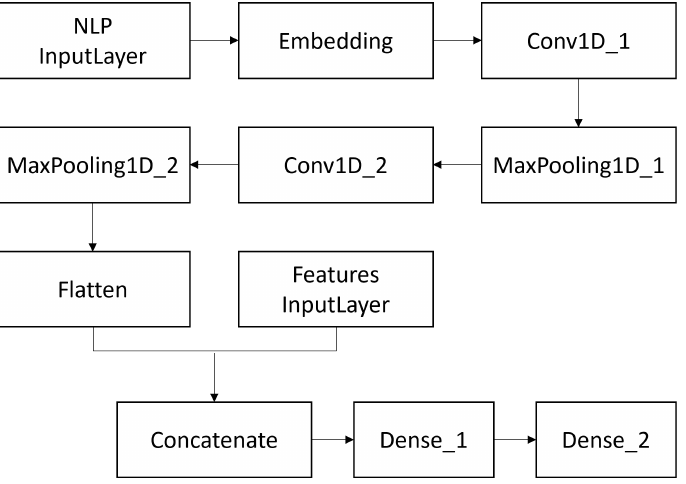
Figure 2. Architecture of the Convolutional Neural